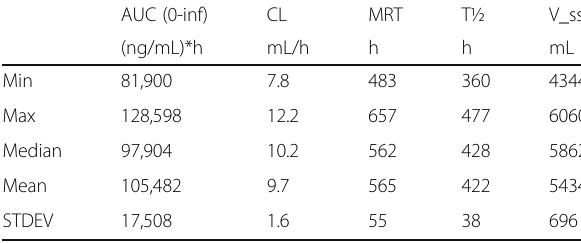
Table 2 Plasma pharmacokinetic parameters for total